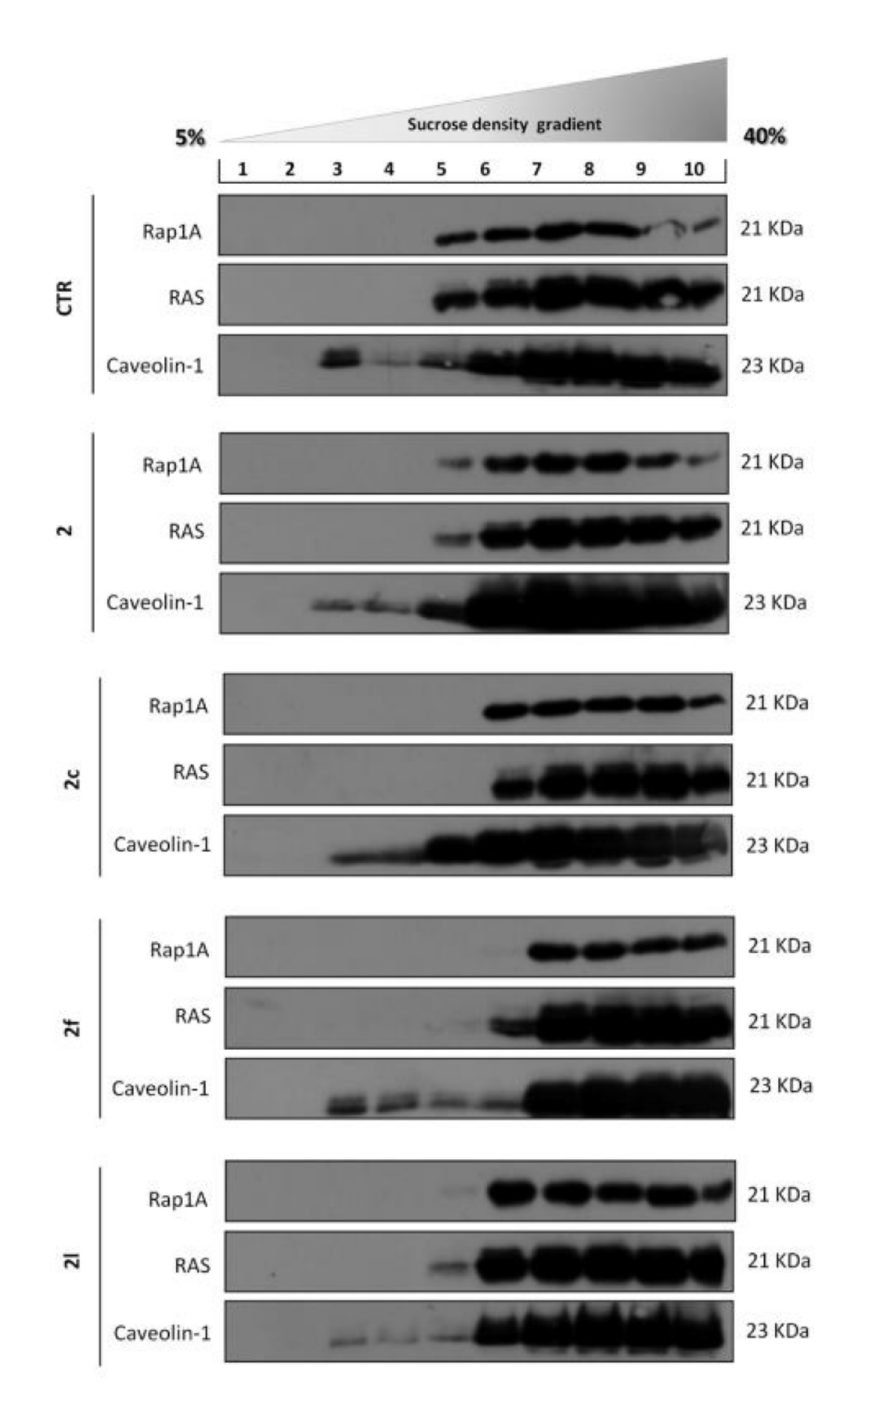
Figure 7. Western blot analysis of sucrose density gradient fractions of HCT116 cells treated with compound 2 and 2a–m (10 µ M for 24 h). 2f induced an accumulation of both RAS and Rap-1A proteins into the top-heavy fractions of the gradient